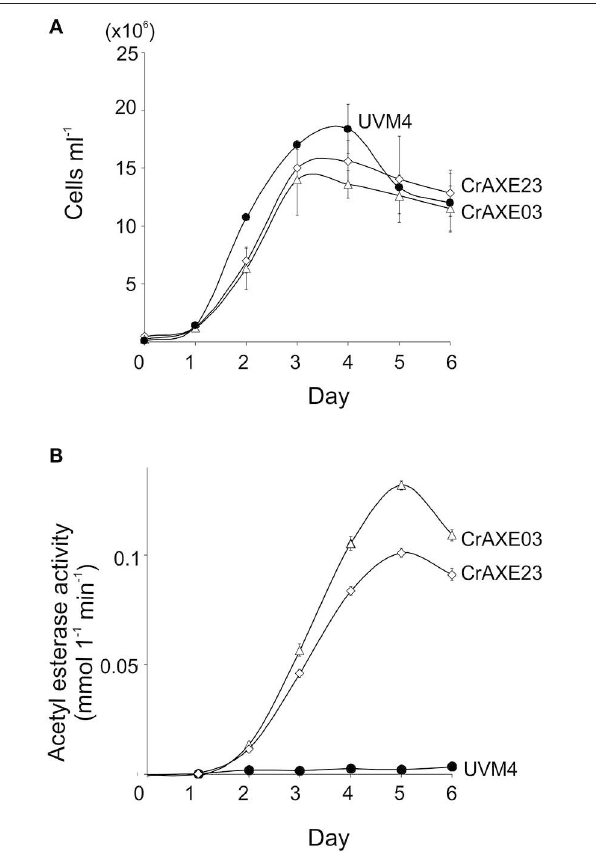
FIGURE 5 | Characterization of the transgenic strains CrAXE03 and CrAXE23. (A) Growth curves. (B) Acetylesterase activity in the media as a function of time (days). Three independent cultures were analyzed for each genotype. Standard errors are shown. Two-way ANOVA showed that the growth curves and acetylesterase activities between the UVM4 strains and the transgenic strains (CrAXE02 and CrAXE23) were significantly different ( P <